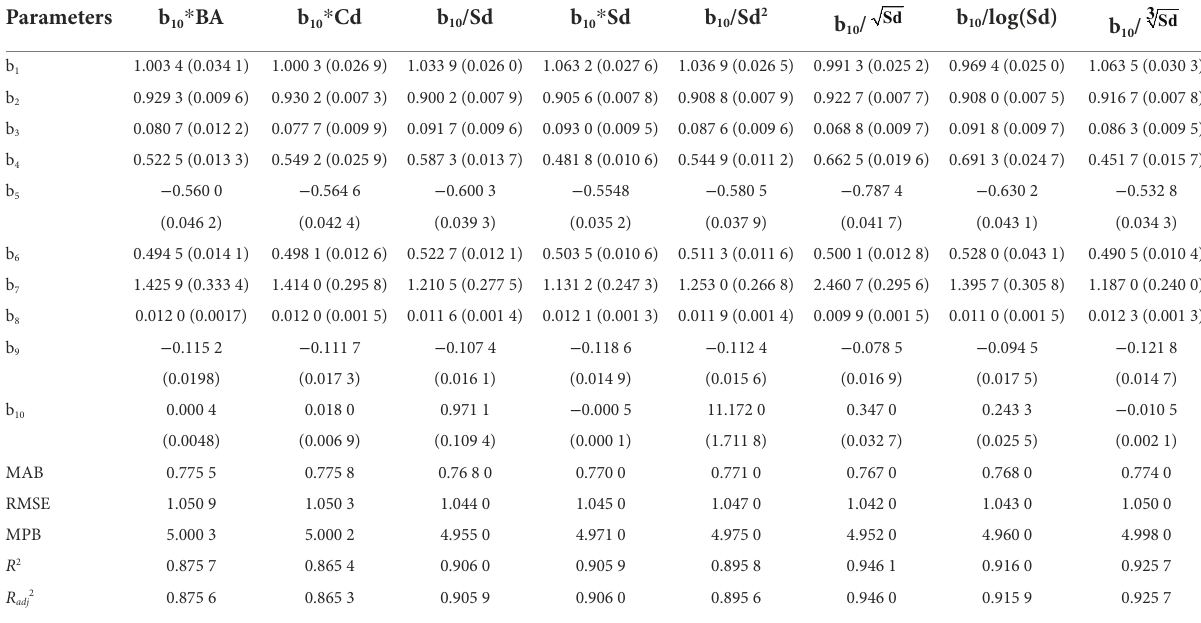
TABLE 5 Parameter estimation and fitting statistics of different density factor taper equations.